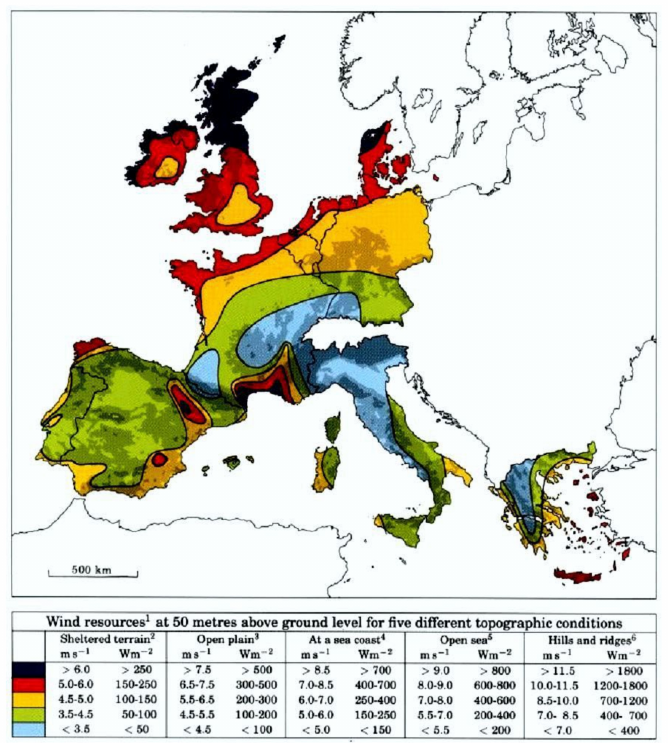
Figure 12. Wind atlas of Europe [33] 1989 DTU Wind Energy, formerly Risø National Laboratory. The velocity of the rider is chosen to represent a typical velocity he might achieve in a race. Under still wind conditions, a cyclist may develop a speed of 45 km/h; therefore,